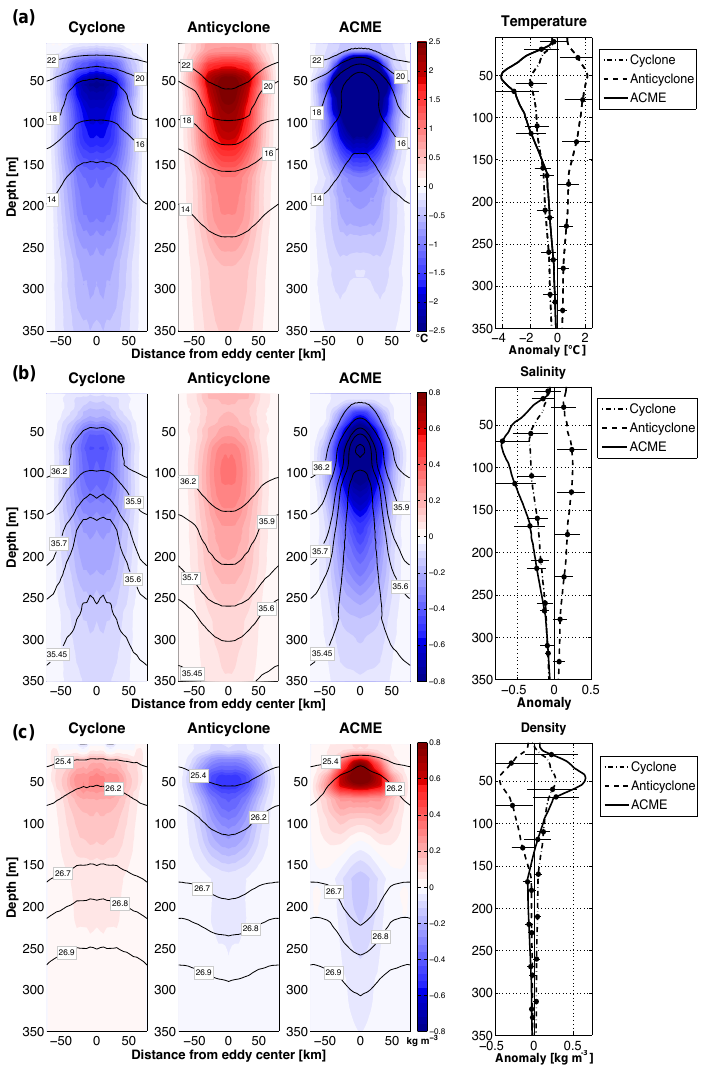
Figure 12. Vertical structure of the composite cyclone, anticyclone, and ACME in the TANWA as presented as sections through the eddy center (left three columns) and mean anomaly profiles (right column). In (a) potential temperature anomaly, in (b) salinity anomaly, and in (c) potential density anomaly as calculated by using the nearest profile outside of the eddy is shown. Black contour lines in the left three columns mark isolines of temperature (c) , salinity (b) , and potential density (c) . In the right column, solid lines represent the composite ACME, dashed lines the anticyclone, and dashed-dotted lines the cyclone; the error bars at selected depths represent the standard deviation calculated from the individual anomaly